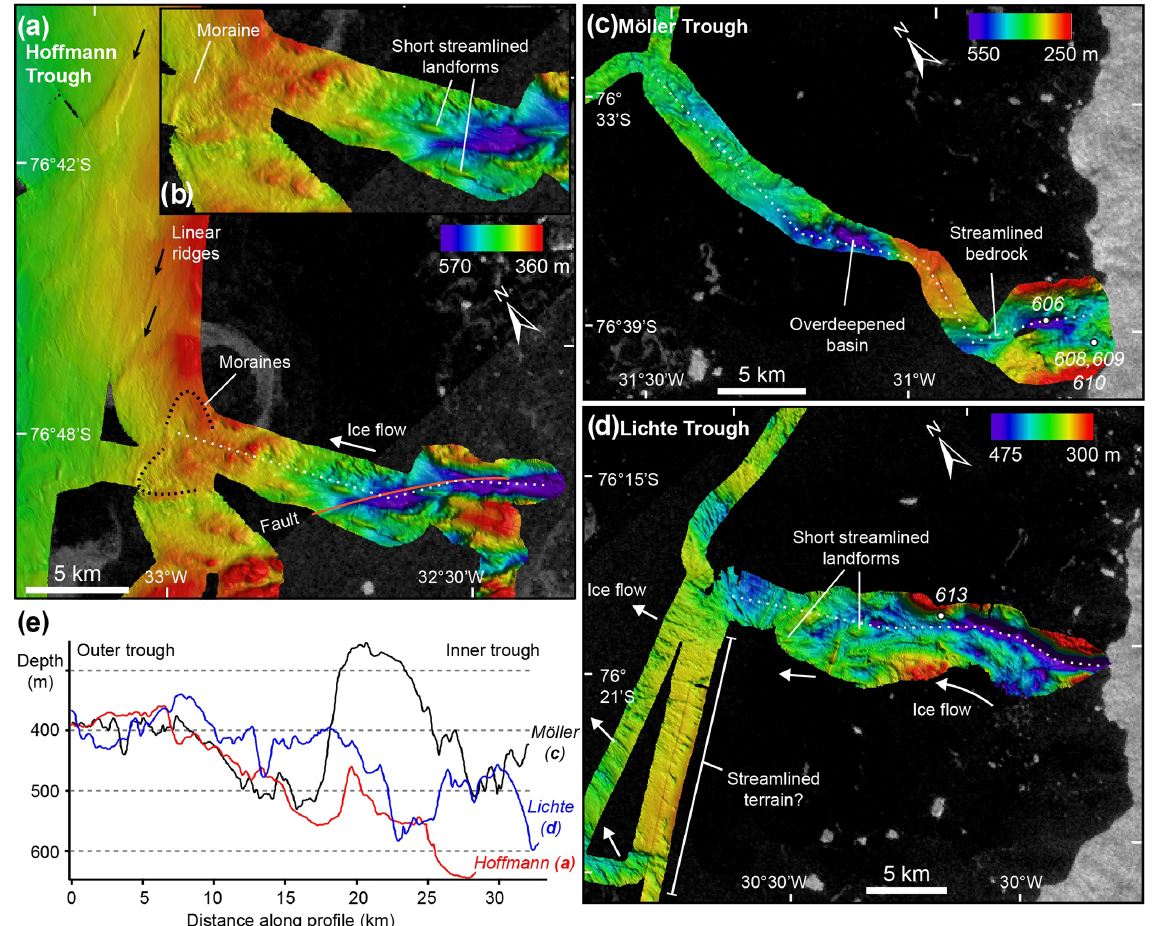
Figure 2. Geomorphology of glacial troughs downstream of low-velocity glaciers ( < 250myr − 1 ) : (a, b) Hoffmann Trough, (c) Möller Trough and (d) Lichte Trough, with labelled examples of streamlined landforms, moraines and bedrock terrain. Sediment core locations are marked by white circles with associated core numbers. Background image is an Envisat synthetic aperture radar image from 21 February 2011 to show the position of the ice front during the survey (cruise JR244). (e) Long profiles down the central axis of the troughs showing rugged but generally landward-dipping geometries; profile locations are marked with white dotted lines in panels (a) , (c) and (d)